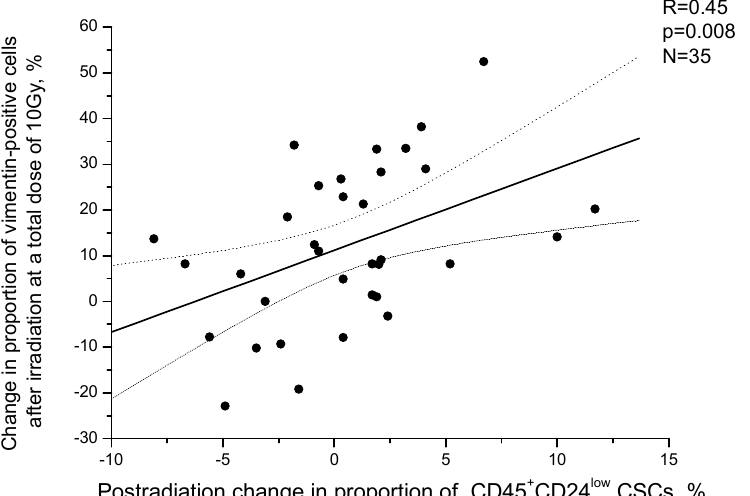
Figure 12. Correlation of changes in the proportion of vimentin-positive cancer cells in cervical scrapings from CC patients with changes in the proportion of CSCs after irradiation at a TD of 10 Gy. Positive values on the X and Y axes indicate an increase in the corresponding indicators after irradiation, whereas negative values indicate a decrease in these indicators compared to those before treatment. The dotted lines indicate 95% confidence limits for linear regression (solid line).